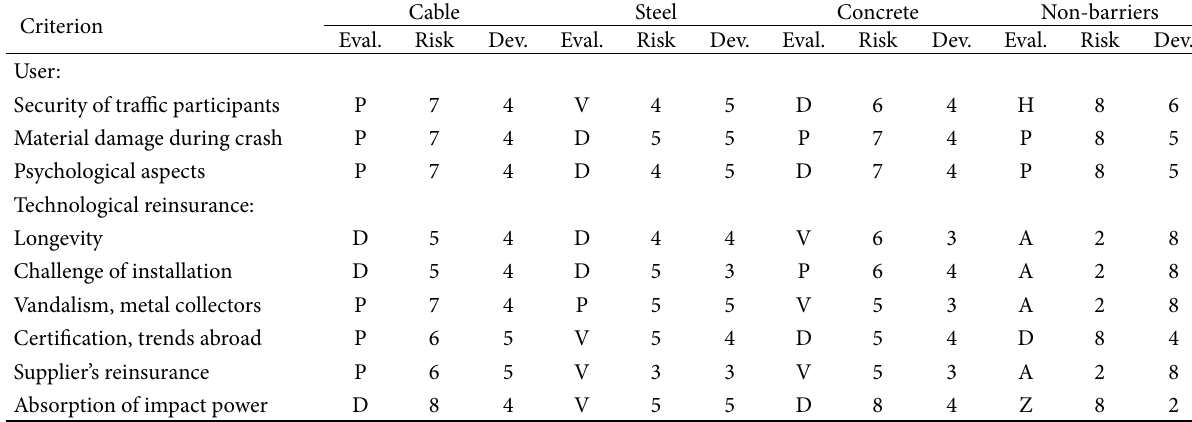
Table 5. Expert evaluation of variants (part II) Criterion